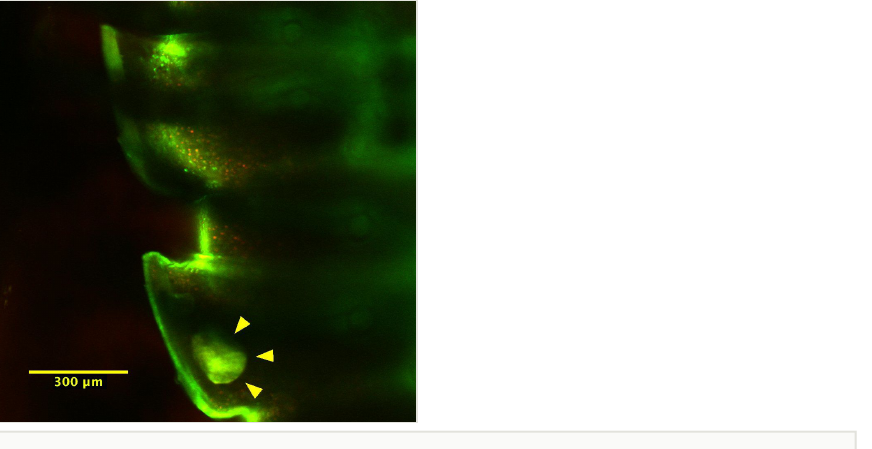
Top view of the juvenile millipede; the bright fi eld in the lower fl ange is a gland storage